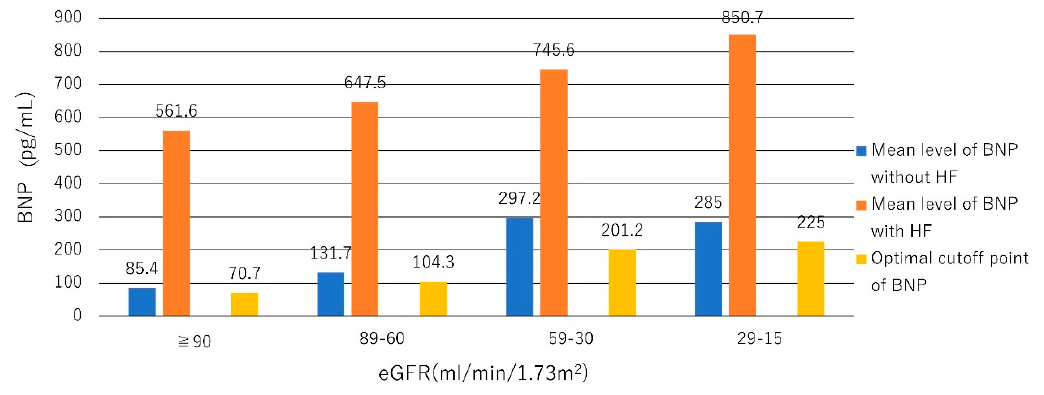
Figure 1. Correlations between B-type natriuretic peptide (BNP) and estimated glomerular filtration rate (eGFR) values. The level of BNP is influenced by renal function, especially when the eGFR is less than 60 mL/min/1.73 m 2 . The BNP cut-off points for the diagnosis of heart failure (HF) may need to be raised in renal dysfunction [51].